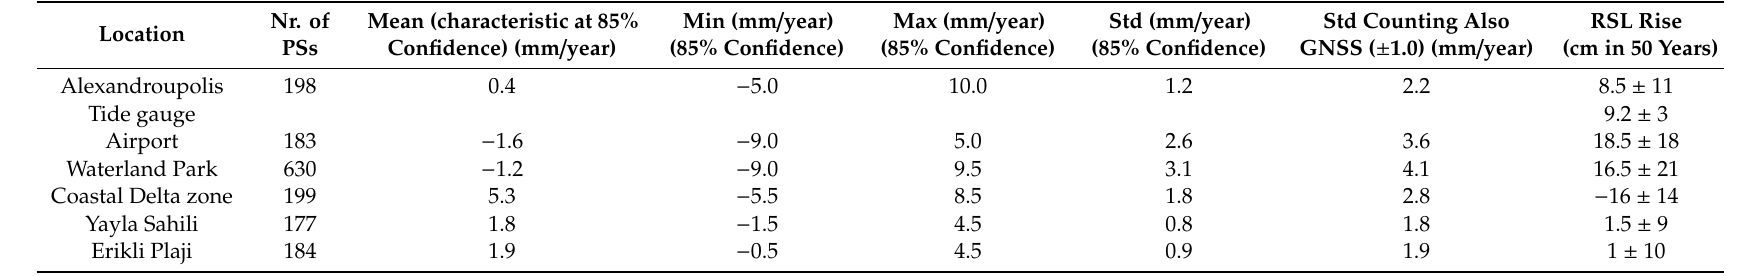
Table 3. Statistics of the sub-areas of Alexandroupolis, Evros Delta. Amongst others, the characteristic (mean) values of vertical deformation rate, the relative sea-level rise, and the uncertainty are shown. The sub-area Coastal Delta zone presents negative sea-level rise, thus sea-level falling. PS stands for permanent scatterers; GNSS for Global Navigation Satellite System; RSL for relative sea